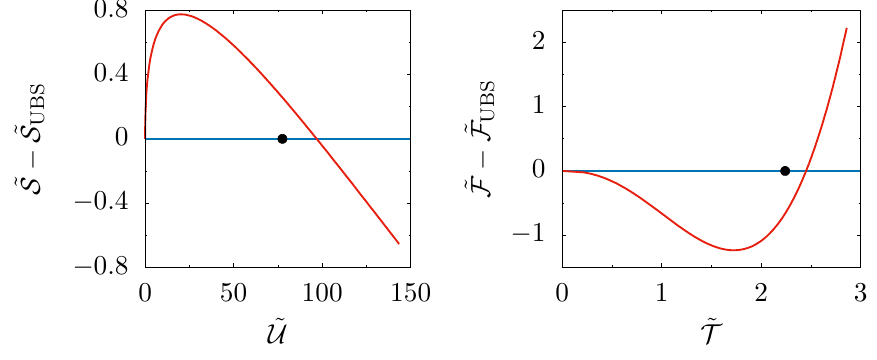
Figure 4 . Phase diagram of = (8 ; 8) SYM on a circle with length L in the microcanonical (left) N and canonical (right) ensemble. We plot the di(cid:11)erence of entropy and free energy, respectively, to the corresponding values of the uniform branch, which is thus represented as the blue zero line in these diagrams with the black circle indicating the solution where the Gregory-La(cid:13)amme instability arises. The localized branch, represented by the red line, is thermodynamically favored over the uniform branch for small masses or small